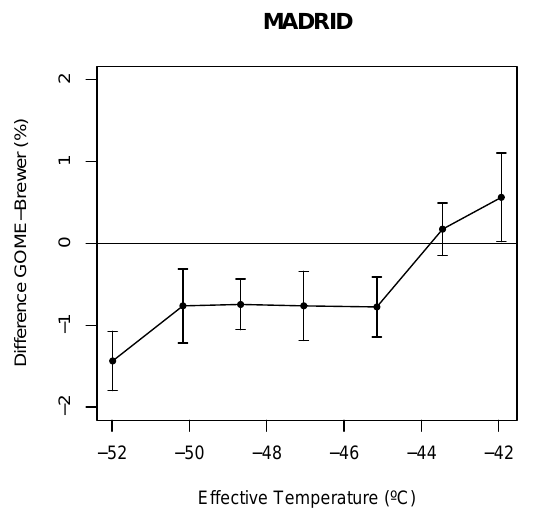
Fig. 6. Temporal evolution of effective temperature at the Madrid station.